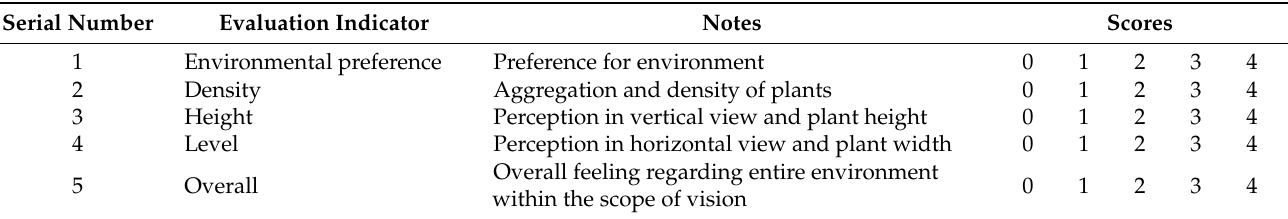
Table 2. Environmental preference and spatial scale for deciduous landscape